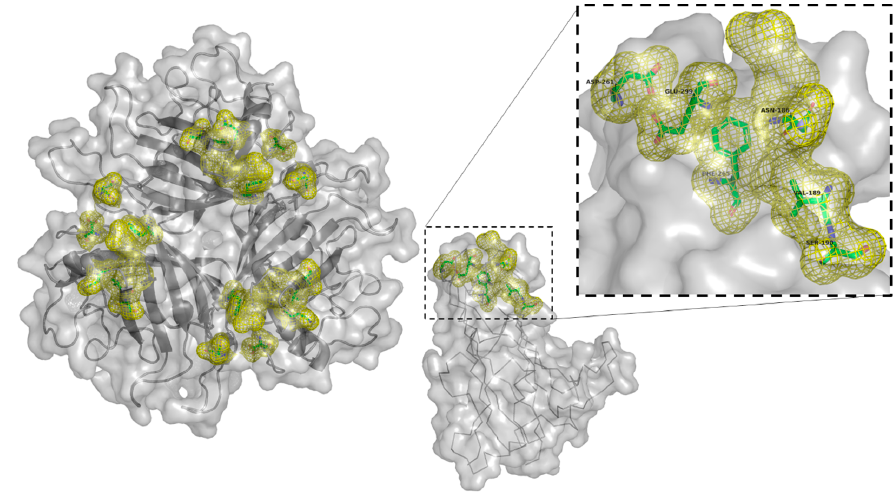
Figure 5. DSG2 interacting residues, and known mutation sites, within the Ad3 fiber knob domain: The key residues which interact with DSG2 are shown as green sticks. The yellow surface shows the region in which known mutations which abrogate DSG2 interaction occur. Structure from PDB: 1H7Z.